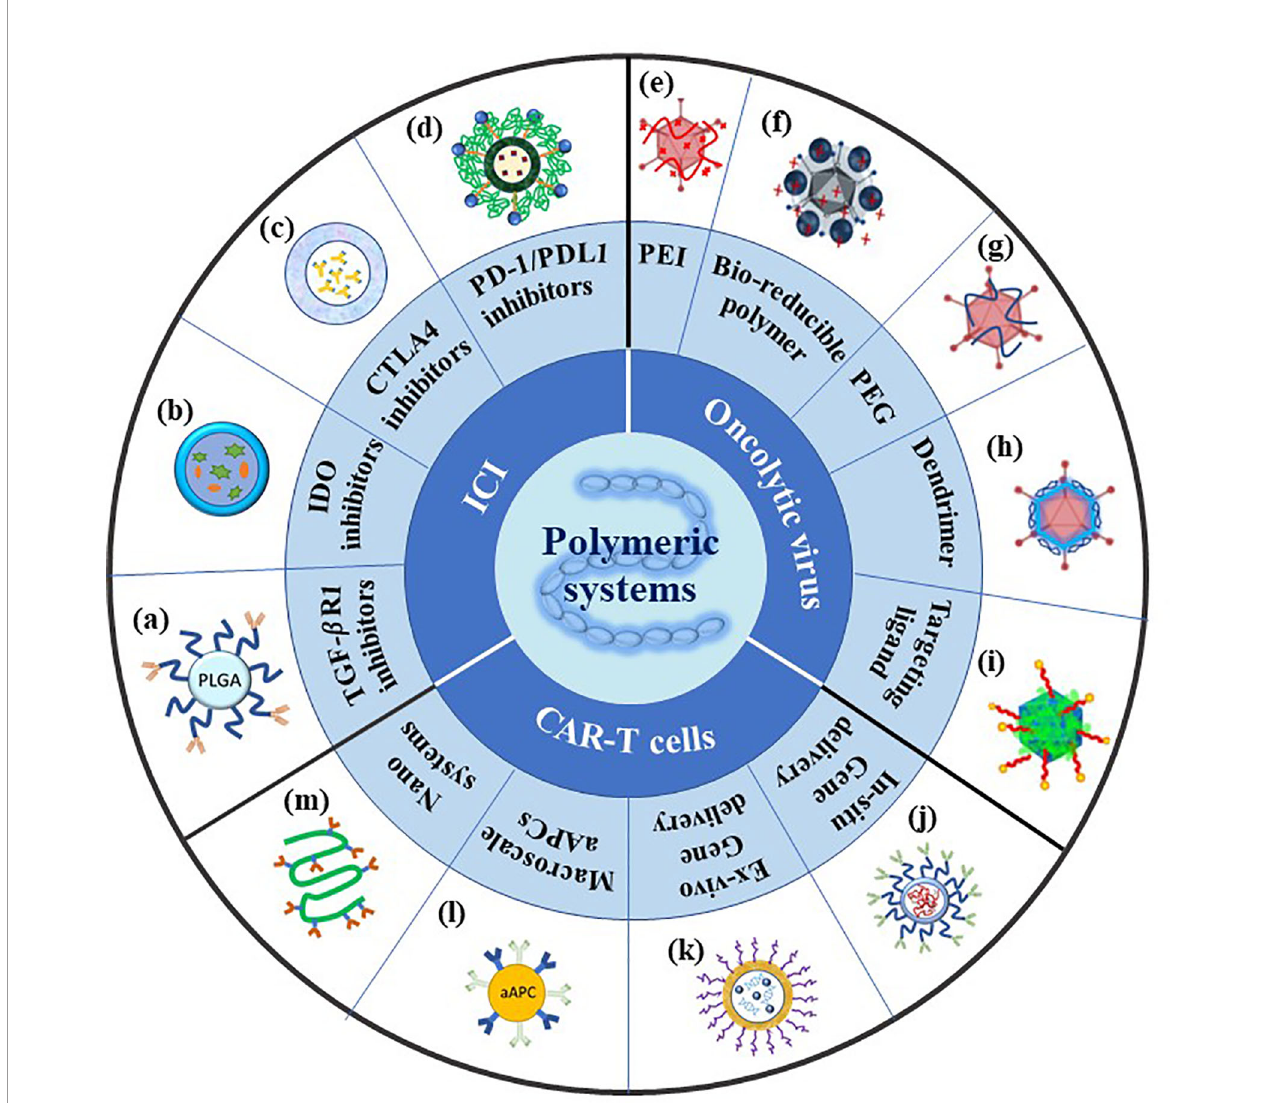
FIGURE 1 | Summary of polymeric systems for cancer immunotherapy. ICI: (A) Scheme of antibody conjugated PEG-PLGA polymeric nanoparticles recreated referencing from (50); (B) scheme of NLG919(IODI)/IR780 coloaded micelles recreated referencing from (51); (C) scheme of polymeric micelles containing ICI antibodies recreated referencing from (52); (D) scheme of PEG sheddable, anti-PD-1 antibody (aPD-1)-conjugated, and PTX-loaded micelle recreated referencing from (53); OV: (E) Scheme of cationic PEI-Ad complex created referencing from (54); (F) scheme of PPSA-Ad complex reused referencing from our group (55); (G) scheme of PEG conjugated-Ad created referencing from (56); (H) scheme of amphiphilic dendrimer binding Ad recreated referencing from (57); (I) scheme of Ad/ chitosan-PEG-FA nanocomplex reused referencing from our group (58); CAR-T cells: (J) Scheme of targeted mRNA-carrying polymeric nanoparticle recreated referencing from (59); (K) scheme of targeted pDNA-carrying supramolecular self-assemble nanoparticles recreated referencing from (60); (L) scheme of arti fi cial antigen presenting cell recreated referencing from (61); (M) scheme of semi-stiff synthetic dendritic cells recreated referencing from